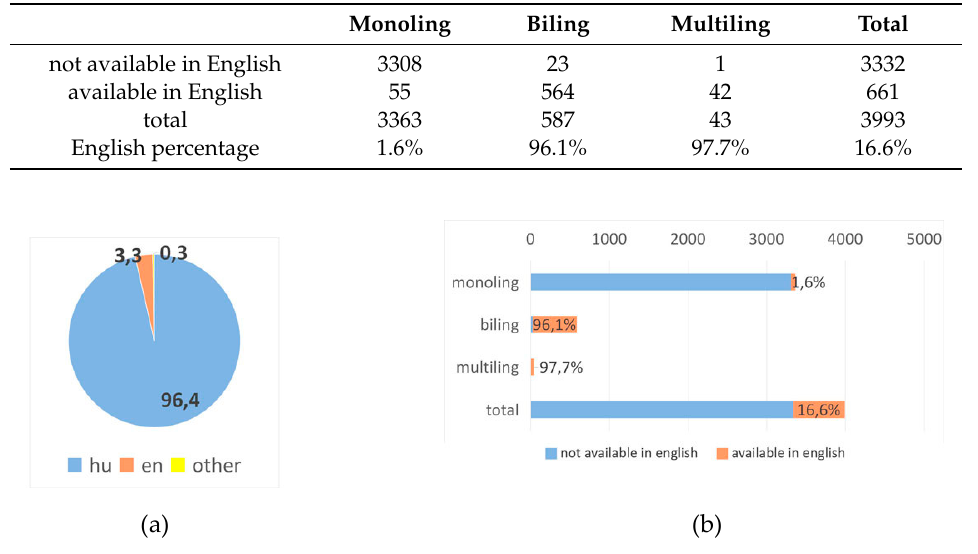
language availability bar chart.